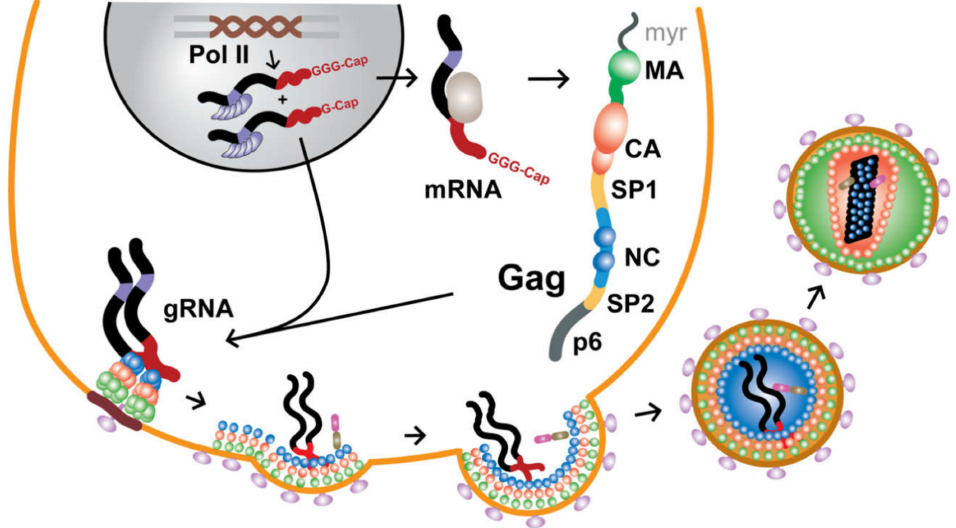
Figure 1. Late phase of the HIV-1 replication cycle. Heterogeneous transcriptional start site usage a ff ords 5 (cid:48) -capped transcripts beginning with a single guanosine that function as genomes (gRNA) and are packaged as dimers, as well as 5 (cid:48) -capped transcripts beginning with two (minor species, not shown) or three guanosines that function as mRNAs (5 (cid:48) -leader, coding region, and Rev-binding sites of the viral RNA shown in black, red, and gray,